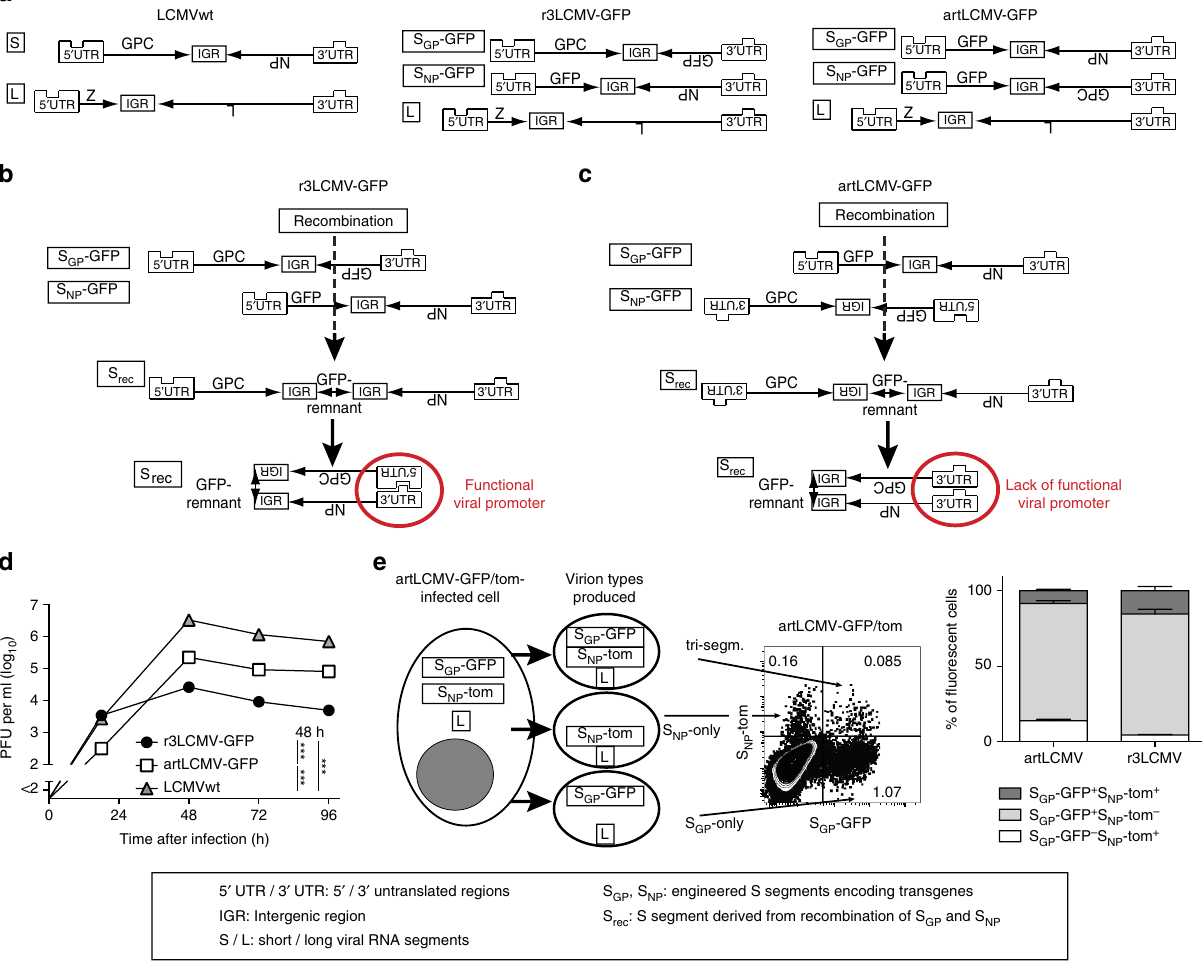
Figure 1 | Genetic design and growth of artLCMV in cell culture. ( a ) Genome organization of LCMVwt, r3LCMV-GFP and artLCMV-GFP. ( b ) Non-homologous recombination unites GPC and NP ORFs of r3LCMV-GFP yielding S rec with only GFP remnants. 3 0 UTR and 5 0 UTRs of S rec pair to form a functional promoter (Supplementary Fig. 2). ( c ) Hypothetical recombination event uniting GPC and NP of artLCMV-GFP at the expense of losing the 5 0 UTR. Duplicated 3 0 UTRs on such hypothetical S rec cannot form a functional promoter. ( d ) Growth kinetics of LCMVwt, artLCMV-GFP and r3LCMV-GFP on BHK-21 cells. Symbols represent the mean of three replicates (s.e.m. hidden in symbol size). PFU: plaque forming units. N ¼ 3 ( N : number of independent data sets). ( e ) artLCMV-GFP/tom and r3LCMV-GFP/tom (containing S GP -GFP and S NP -tom) contained tri-segmented and bi-segmented particles, which were discriminated and quantified by FACS analysis 12h after infection of BHK-NP cells. Representative FACS plot for artLCMV-GFP/tom (analogous results for r3LCMV-GFP/tom, see quantification in bar graph). Bars represent the mean þ s.e.m. of three replicates per group. N ¼ 3. Data in d (48h after infection) were analysed by one-way analysis of variance (ANOVA) with Bonferroni post hoc test. *** P o